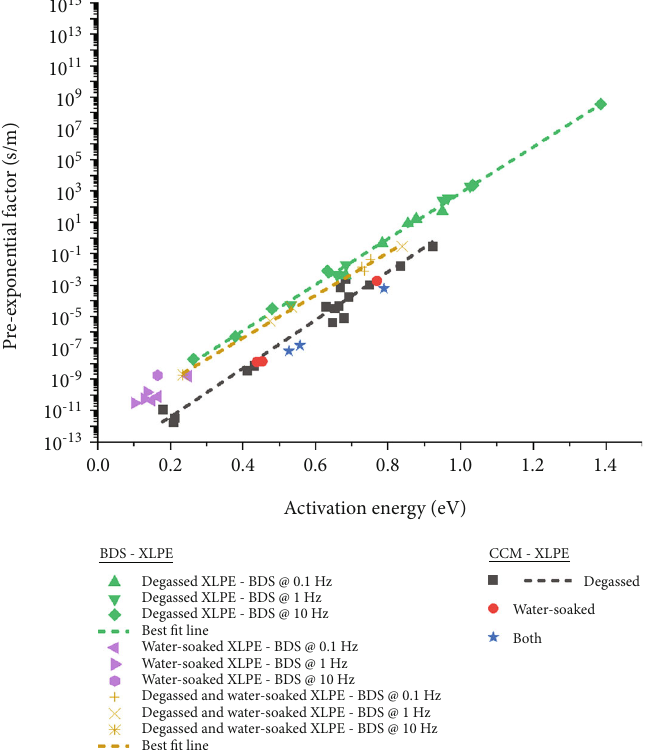
Figure 7: Compensation law plot for XLPE samples that have been both water soaked and degassed. A comparison to the XLPE samples that have been either degassed or water soaked is included in the